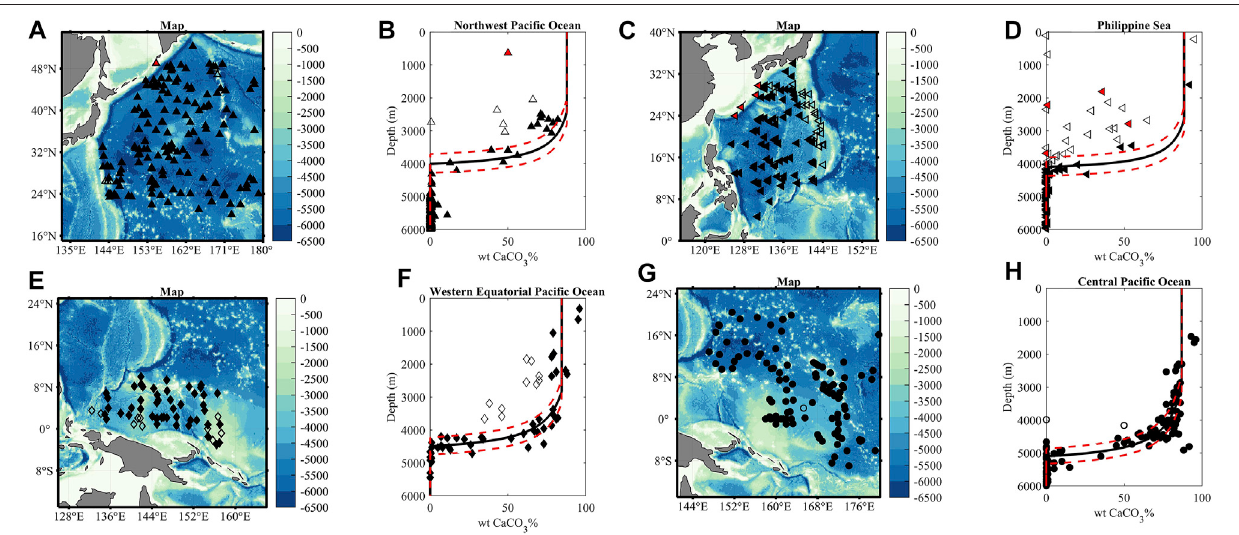
FIGURE 2 | Location of the sampling sites and distributions of sedimentary CaCO 3 in the Northwest Paci fi c Ocean [triangles; (A,B) ], Philippine Sea [left triangles; (C,D) ], Western Equatorial Paci fi c Ocean [diamonds; (E,F) ], and Central Paci fi c Ocean [circles; (G,H) ]. Pelagic sediments with high CaCO 3 content presumably not stronglyaffectedbynon-carbonatedilutionaremarkedby fi lledblacksymbols,whilethosewithlowCaCO 3 contentaremarkedbyun fi lledblacksymbols.Samplesfrom ocean margins with low CaCO 3 content are labeled in red [panels (A – D) ]. The solid black lines are model outputs (control runs) for the pelagic Northwest Paci fi c Ocean (A) , Philippine Sea (B) , Western Equatorial Paci fi c Ocean (C) , and Central Paci fi c Ocean. The sensitivity tests with [CO 32 − ] (±~5 μ mol kg − 1 ) are presented by the red dashed